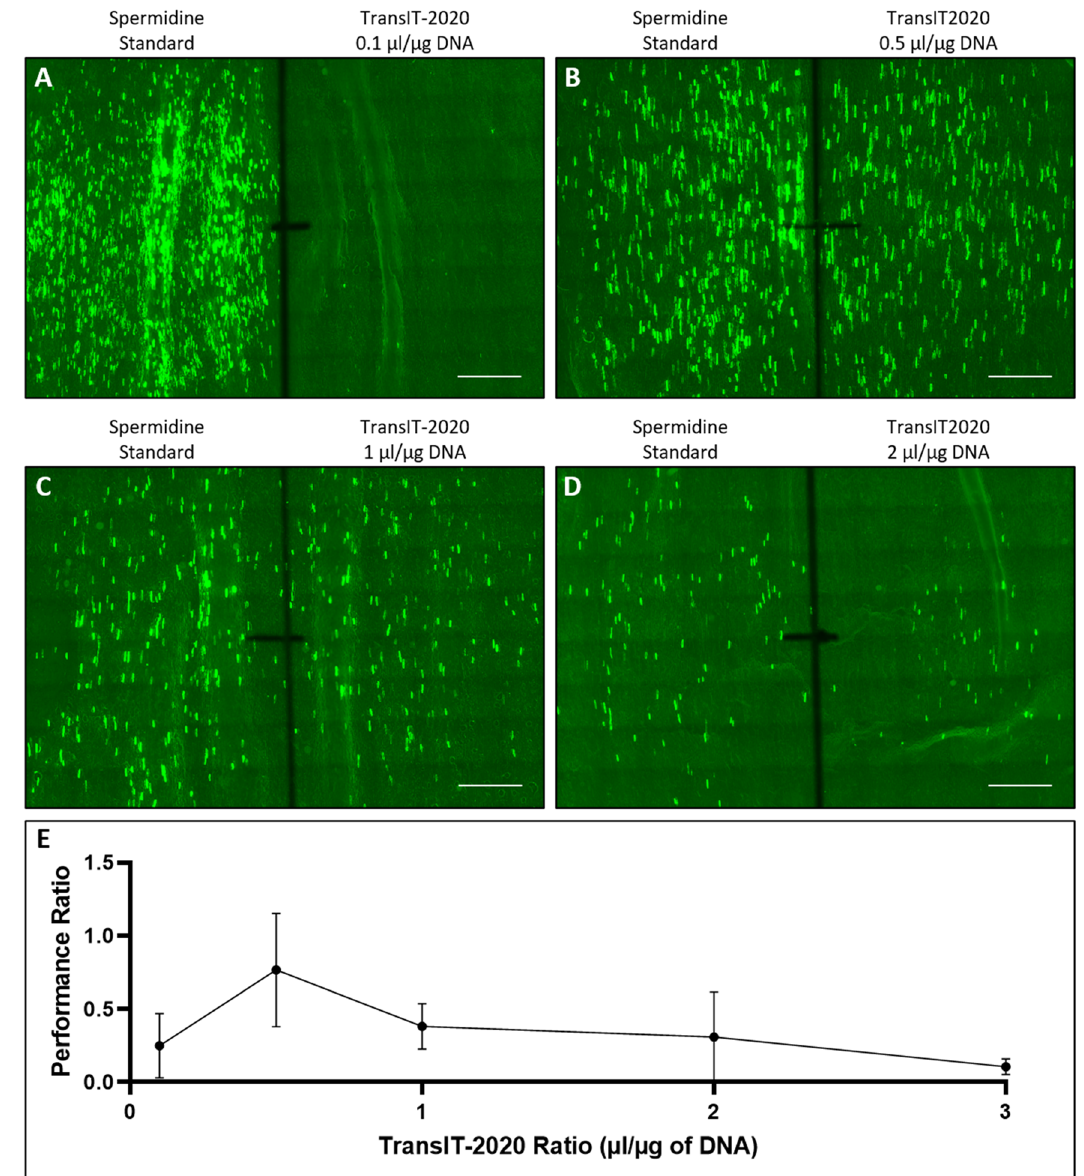
Figure 4. Effect of Trans IT-2020 quantity on DNA delivery. ( A – D ) DNA delivery measured by GFP expressing cells using different quantities of Trans IT-2020 (µL/µg DNA), with spermidine as delivery control. ( E ) Performance ratios for different amounts of Trans IT-2020 showing optimized ratio of 0.5 µL/µg. Scale bar is 4